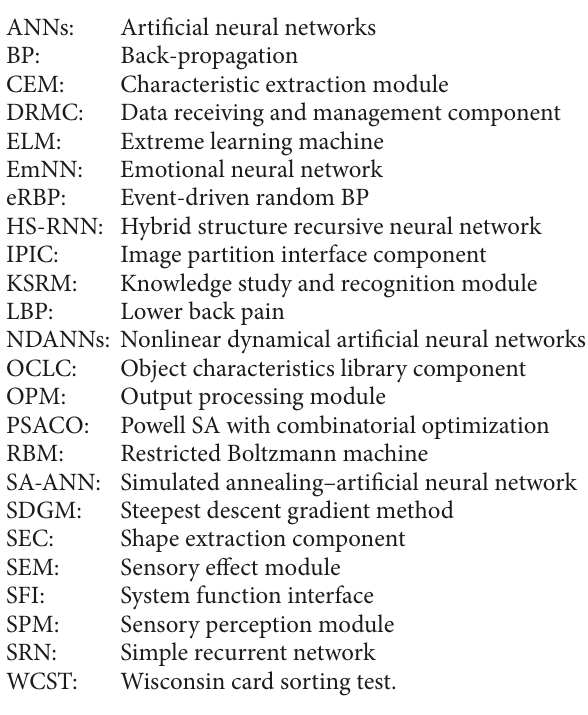
Supplementary 1. Figure s1: Original sample of target objects. Supplementary 2. Figure s2: Damaged sample of target ob- jects. Supplementary 3. Figure s3: Transformed sample of target